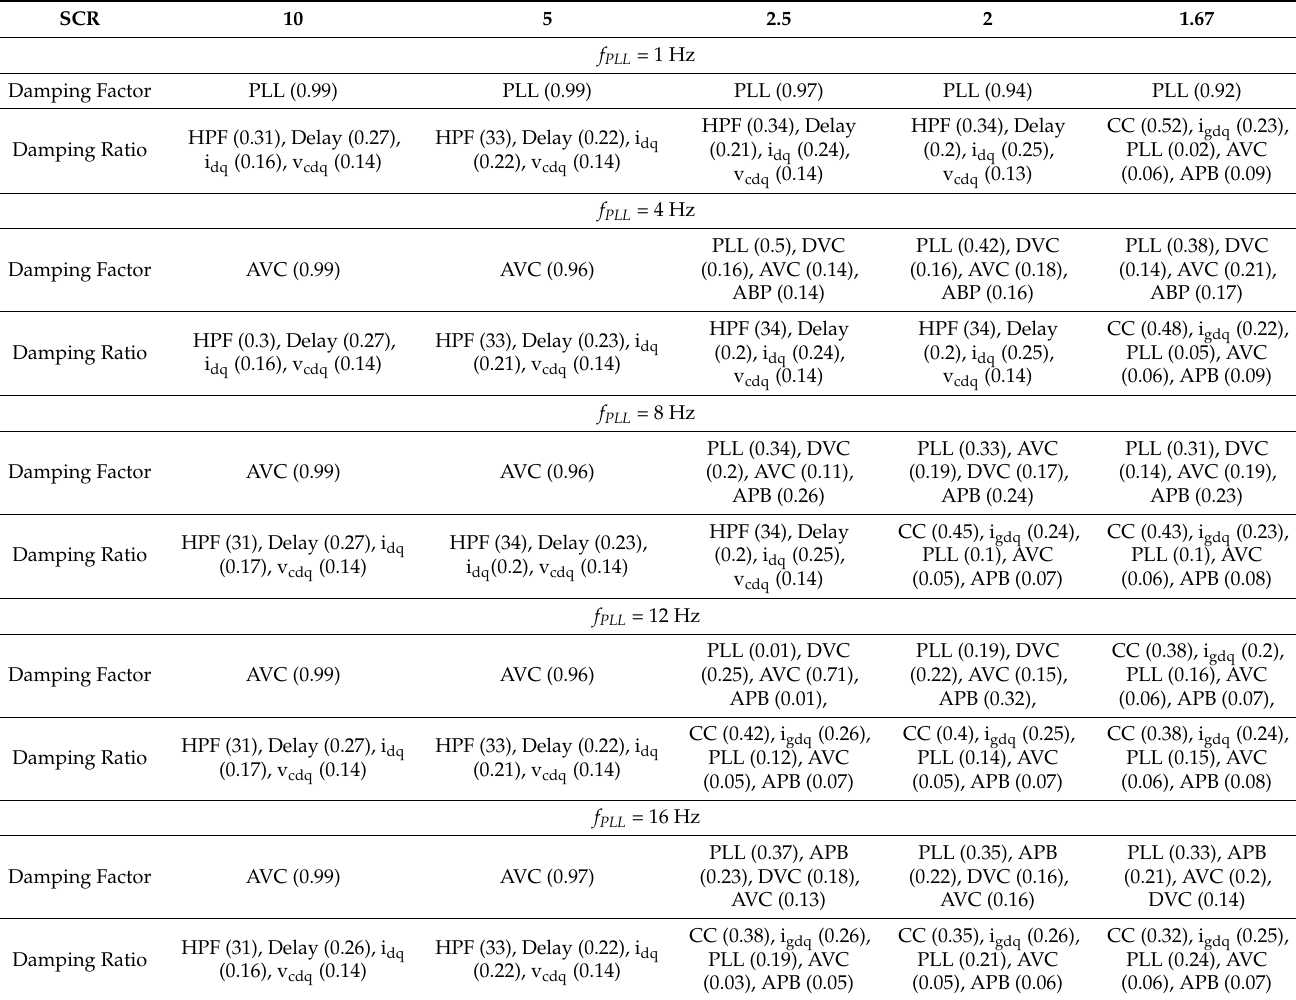
Table 5. Participation factor analysis of critical modes for different grid SCR and PLL bandwidths ( P = P n